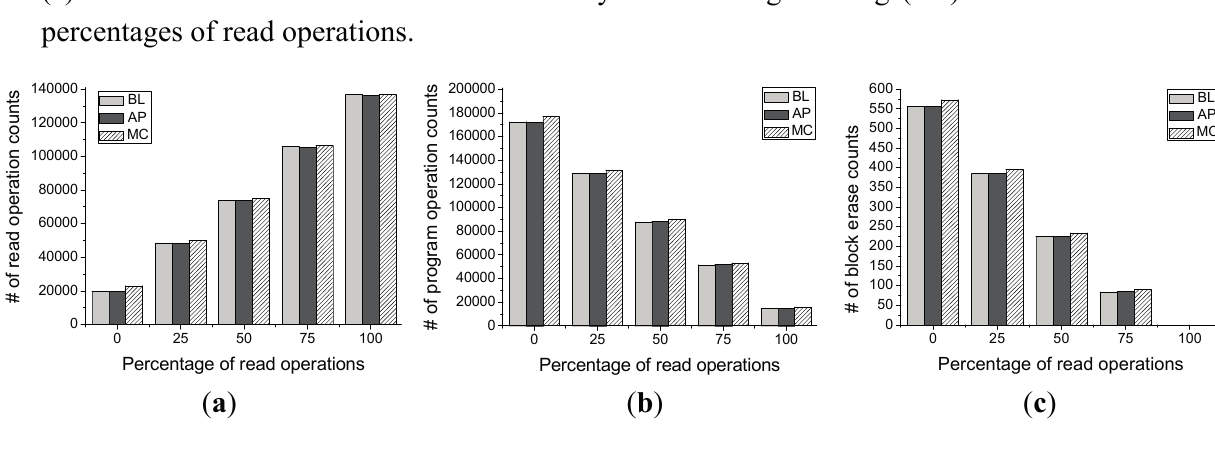
Figure 14. ( a ) The total number of read operations ( b ) The total number of write operations ( c ) The number of block erase counts in Asymmetric Programming (AP) with different ratios of random